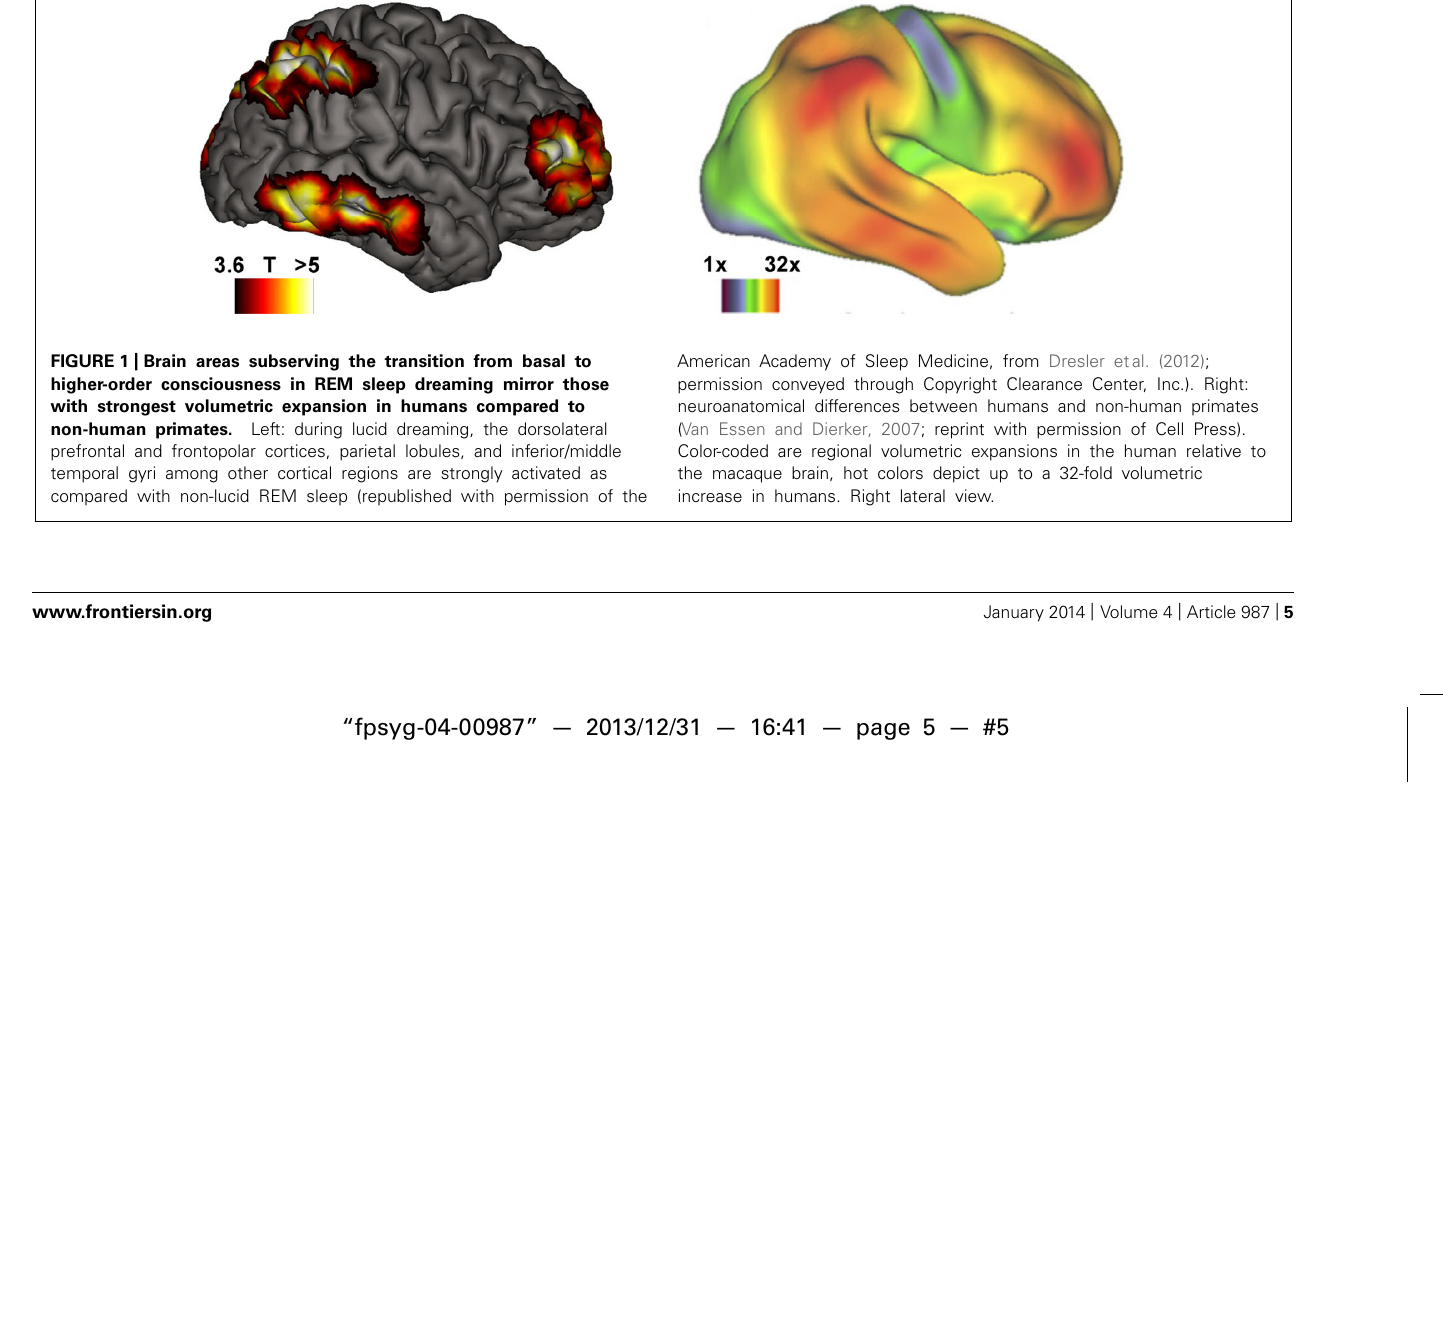
American Academy of Sleep Medicine, from Dresler etal. (2012); permission conveyed through Copyright Clearance Center, Inc.). Right: neuroanatomical differences between humans and non-human primates (Van Essen and Dierker, 2007; reprint with permission of Cell Press). Color-coded are regional volumetric expansions in the human relative to the macaque brain, hot colors depict up to a 32-fold volumetric increase in humans. Right lateral